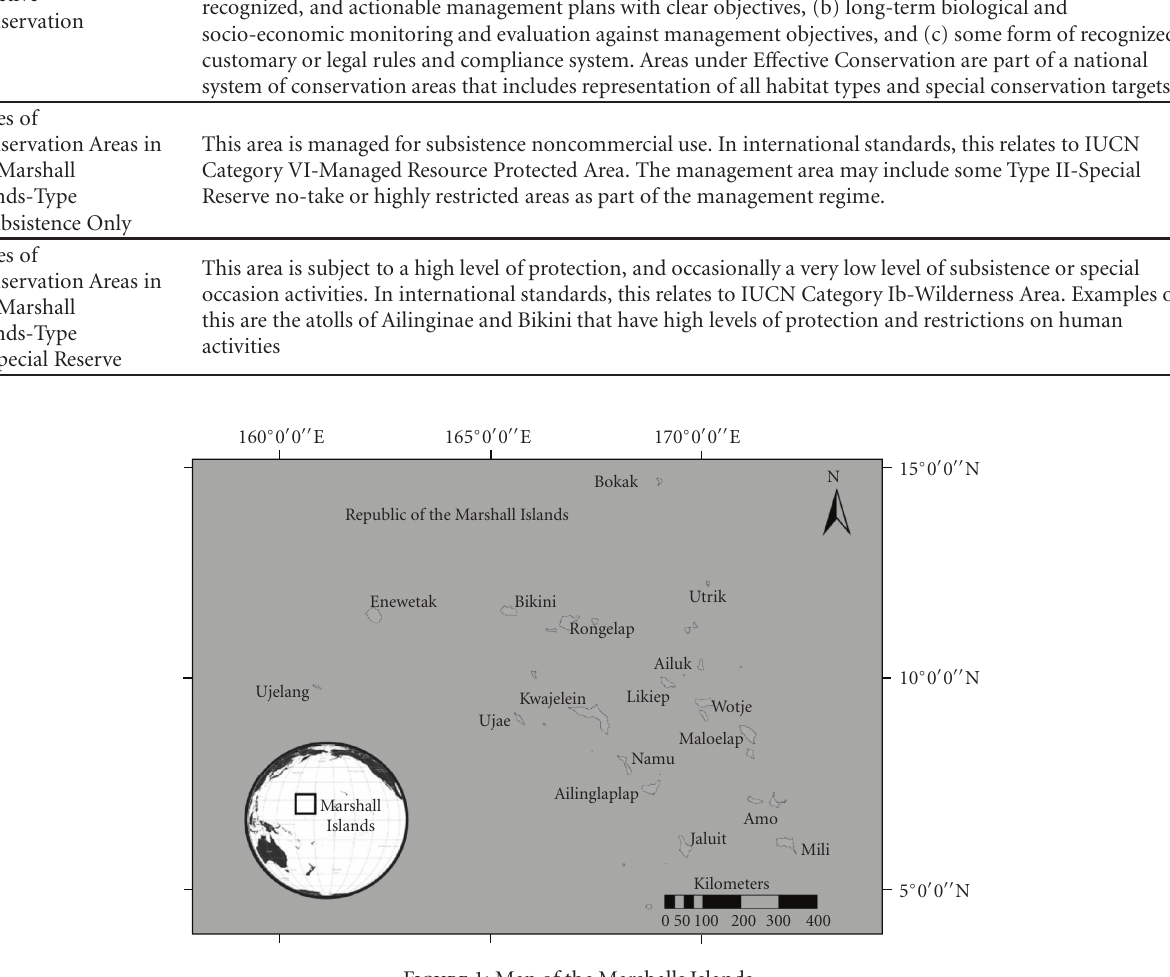
Figure 1: Map of the Marshalls